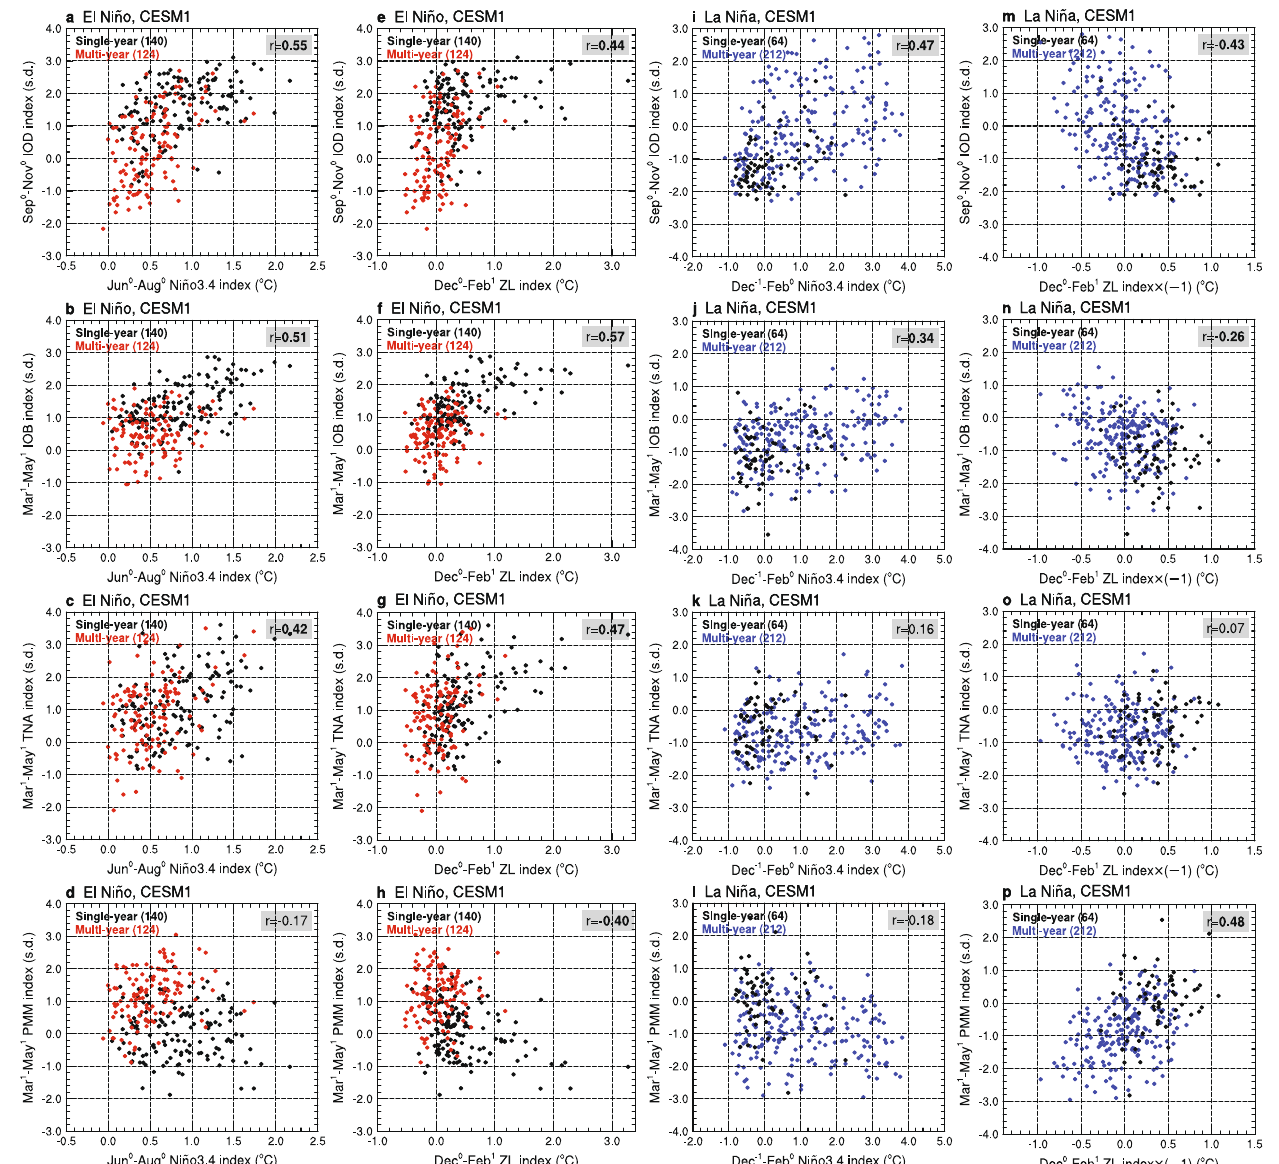
Fig. 3 Relationships between the identi fi ed key factors and various climate indices during single- and multi-year ENSO events. Scatter plot of developing summer Niño3.4 index (represented as developing-season intensity; 1 st column) against the developing fall a IOD index, decaying spring b IOB, c TNA, d PMM indices during the single (black dots) and multi (red dots)-year El Niños in the CESM1. e – h Same as a – d , respectively, except for peak winter ZL index (represented as zonal maximum location; 2 nd column). i – p Same as a – h , respectively, except it displays preceding winter Niño3.4 index (represented as pre-onset Paci fi c condition; 3 rd column) and peak winter ZL index (represented as zonal maximum location, multiplied by − 1; 4 th column) for single (black dots) and multi (blue dots)-year La Niñas. In each panel, a correlation coef fi cient is marked in the upper right corner, with a number in bold denoting statistically signi fi cant at 99.9% con fi dence level based on the Student ’ s t